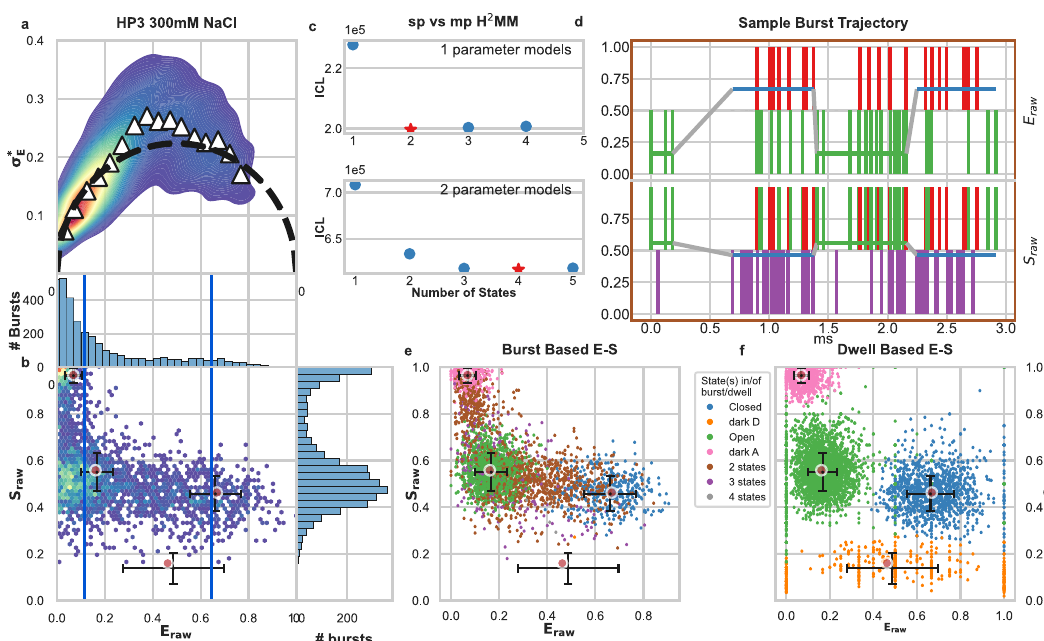
Fig. 2 mpH 2 MM results for DNA hairpin at 300 mM NaCl. a Burst variance analysis (BVA), the E raw standard deviation of E raw values of bursts is displayed versus their E raw values. Bursts with E raw standard deviations higher than expected solely from shot noise (semi-circle), indicate dynamic heterogeneity, such as within-burst FRET dynamics. Triangles indicate the average of standard deviation values per E raw bin. b 2D histogram of E raw and S raw (E-S plots, colloquially) of bursts. The E raw and S raw values of sub-populations derived from mpH 2 MM are marked by red circles, and the E raw and S raw standard deviation of these values, derived from the Viterbi dwell time analysis, are marked by black crosses. c Comparison of values of the integrated complete likelihood (ICL) of spH 2 MM (top panel) and mpH 2 MM (bottom panel) of optimized models with different state models. The most likely state model is marked as a red star. d A sample burst trajectory, with photons represented as colored vertical bars, with donor excitation photons colored green and red for donor and acceptor, respectively. Acceptor excitation photons are colored purple. E raw (top panel) and S raw (bottom panel) of sub-populations determined from dwells using the Viterbi algorithm, are overlayed on the photon bars, and colored to indicate the state of the dwell. The border color also represents the type of burst. e , f E-S scatter plots of data processed by the Viterbi algorithm. Consecutive photons with the same state are considered as a single dwell, E raw and S raw values are then calculated as in Supplementary Eqs. 8 and 9, respectively. MpH 2 MM-derived sub-populations and Viterbi -derived E raw and S raw standard deviations (SD) are overlayed as red circles and black crosses, respectively. e , f E-S scatter plot of bursts e or dwells within bursts f , color coded by which states are present in the bursts ( e ) or according to the state of the dwell (dwell based E raw and S raw de fi ned in Supplementary Eqs. 8 and 9, respectively) f , according to Viterbi algorithm. Color coding is the same throughout d , e , and f . Error bars (s.d.) in b , e , and f are the same, with n = 1232, 466, 3033, and 1493 dwells for the closed, dark donor, open, and dark acceptor states, respectively. See E- τ D analysis in Supplementary Fig. 5, and more examples of bursts classi fi ed by the Viterbi algorithm in Supplementary Fig.